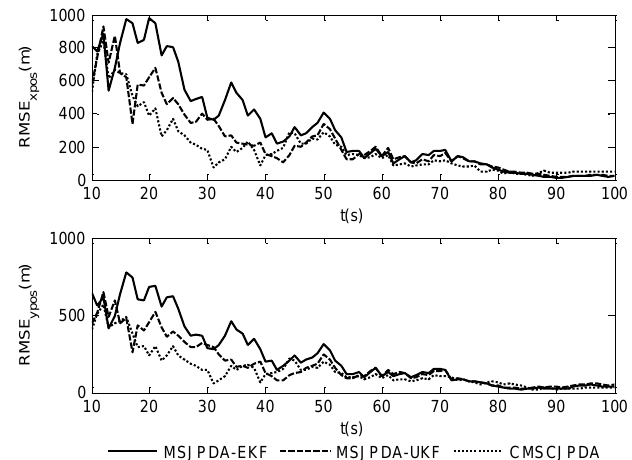
Figure 3. Root mean square position error of target 2.